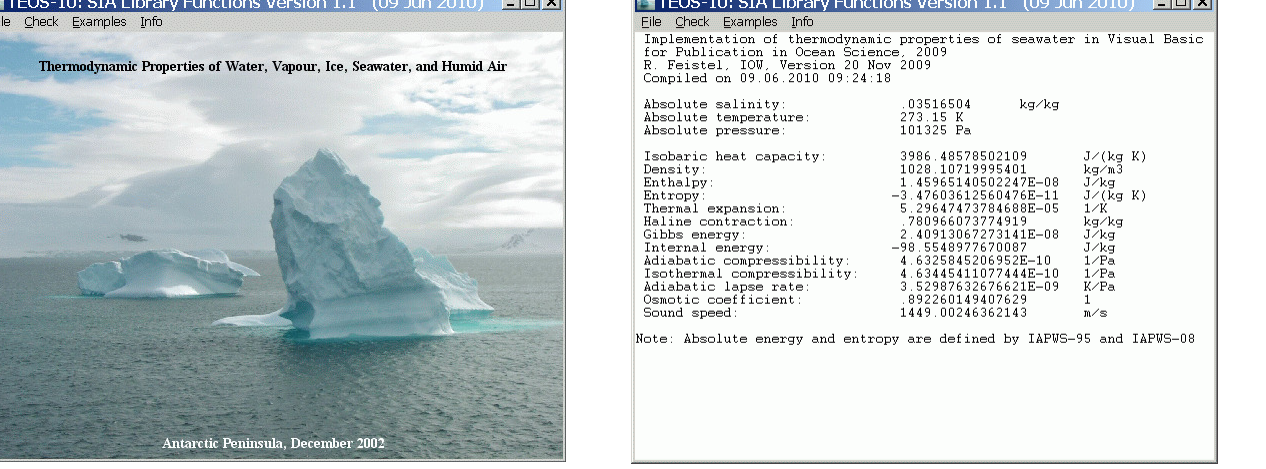
Fig. 4.3: The user interface window of the executable SIA library program of TEOS-10 included with the Visual Basic download. This executable was compiled in Visual Basic and provides access to check tables, check values and a few basic quantities through the pull-down tabs at the top of the window.